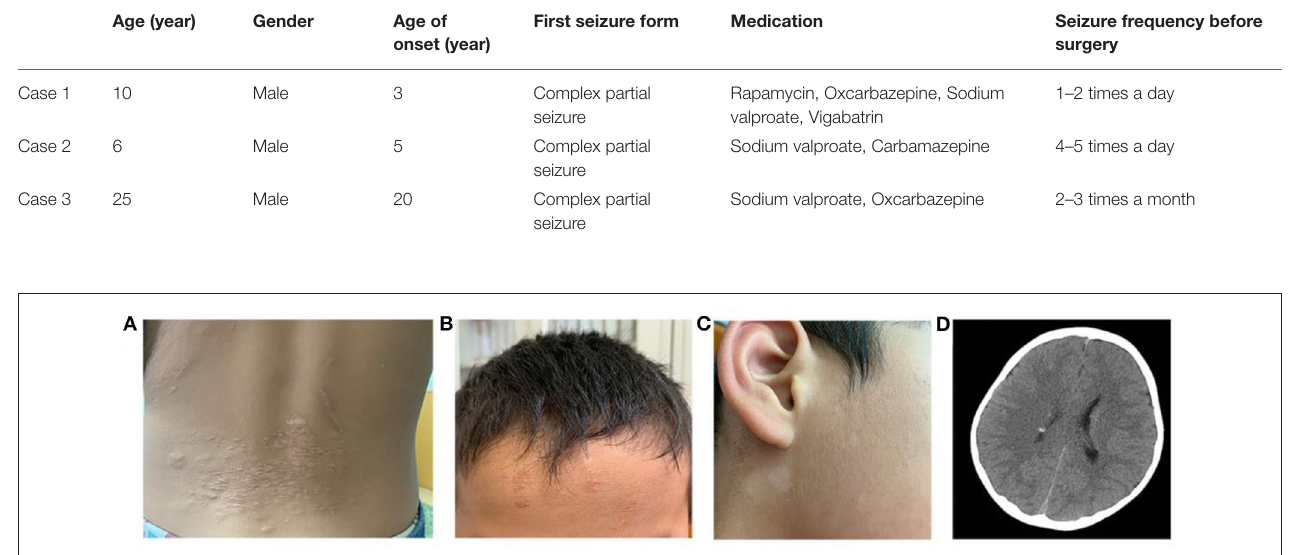
TABLE 1 | Epilepsy history of the three patients.